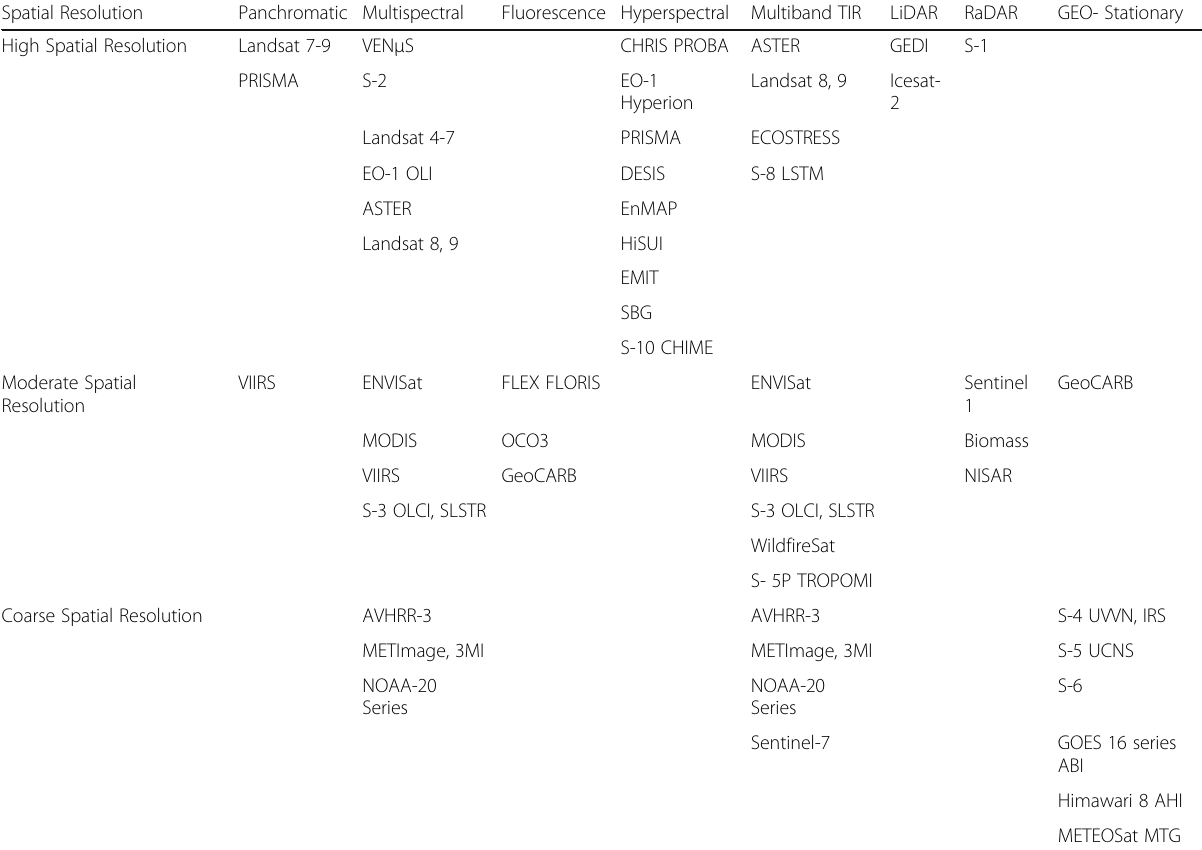
Table 1 Satellites organized by management type, beginning with higher spatial resolution